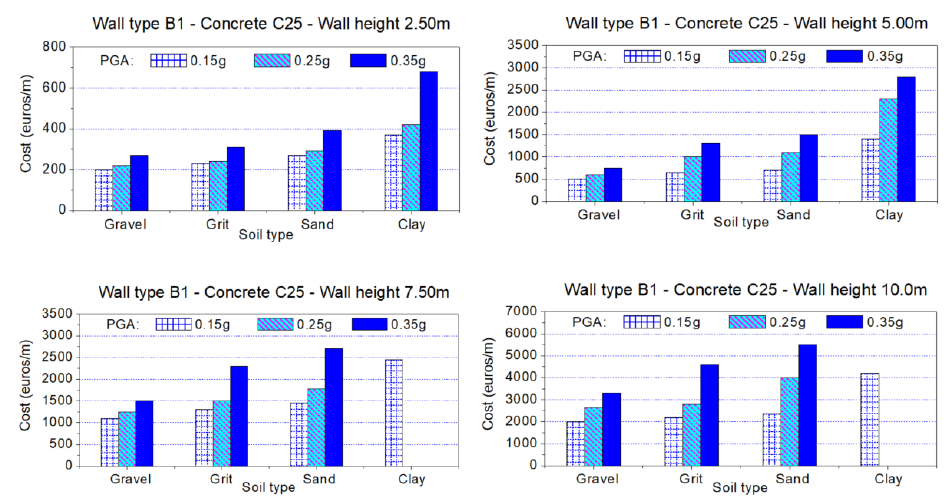
Figure 7. Cost of retaining walls type A2 made by reinforced concrete C30.